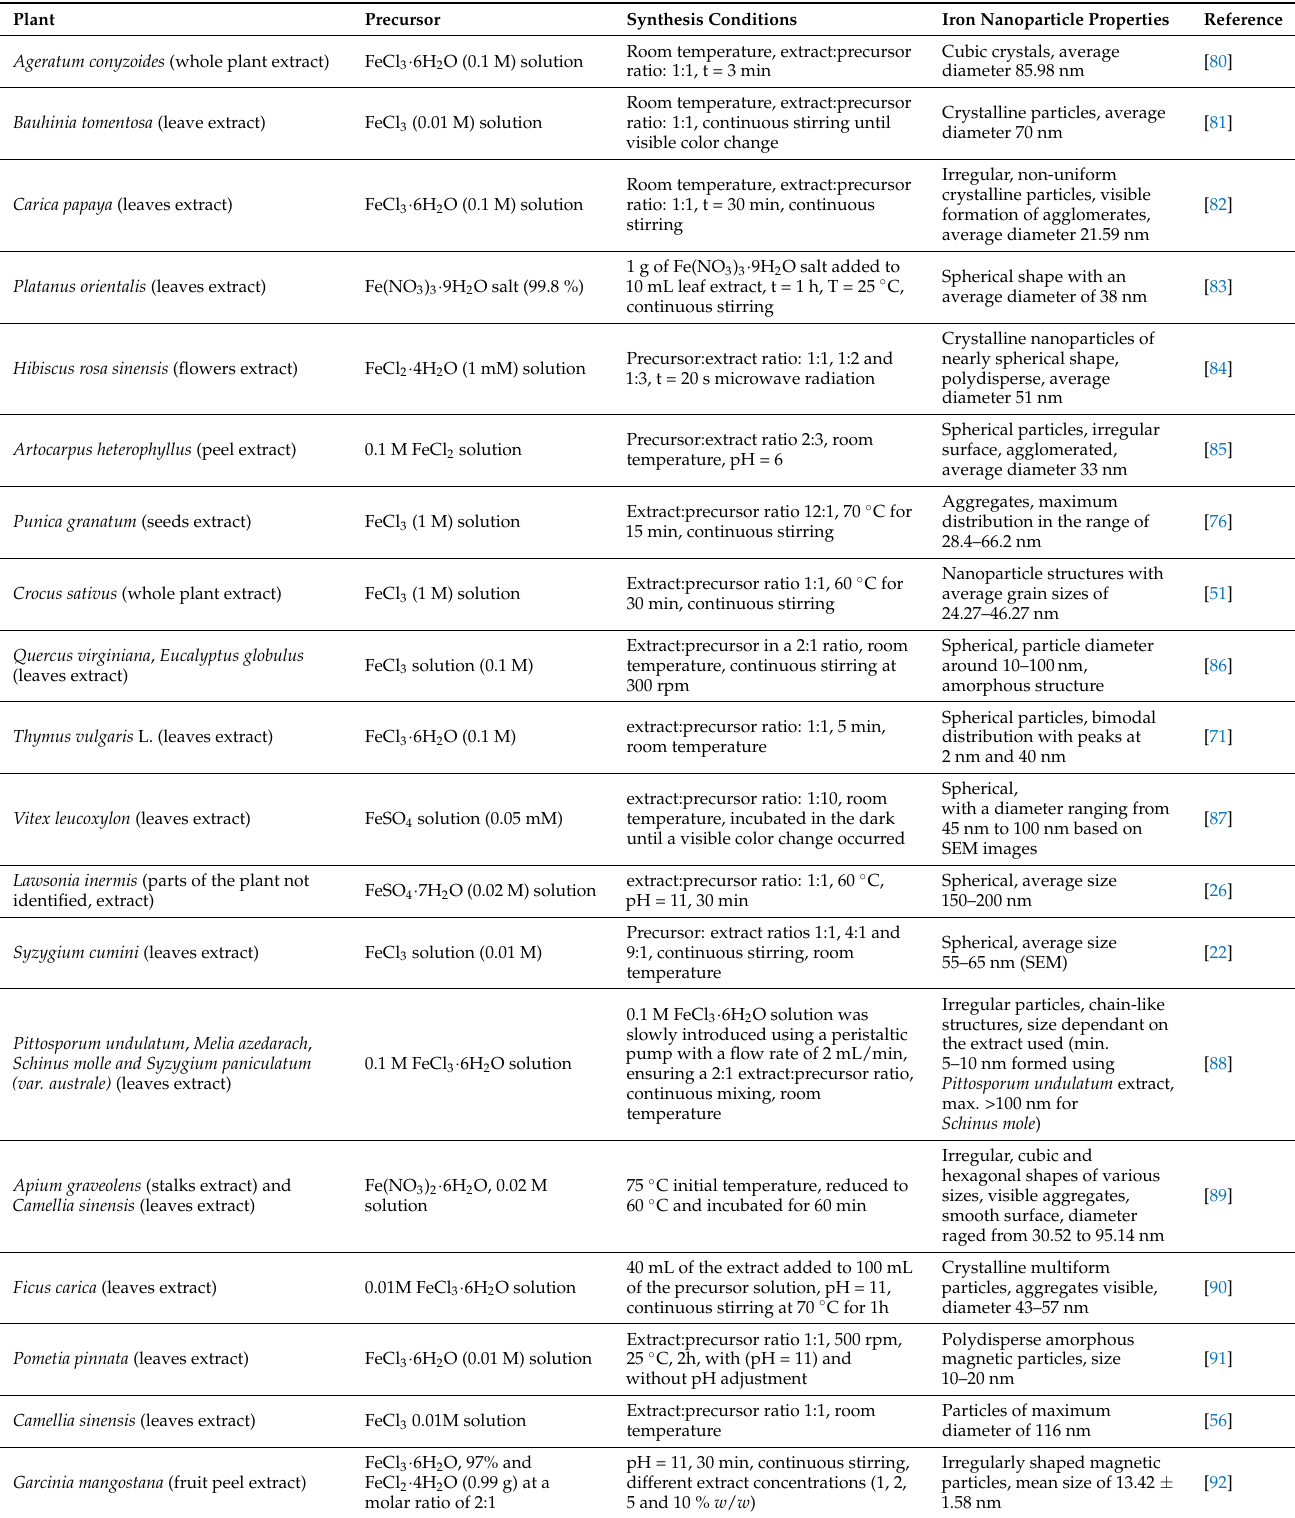
Table 1. An overview of recent studies on iron nanoparticle synthesis using plant